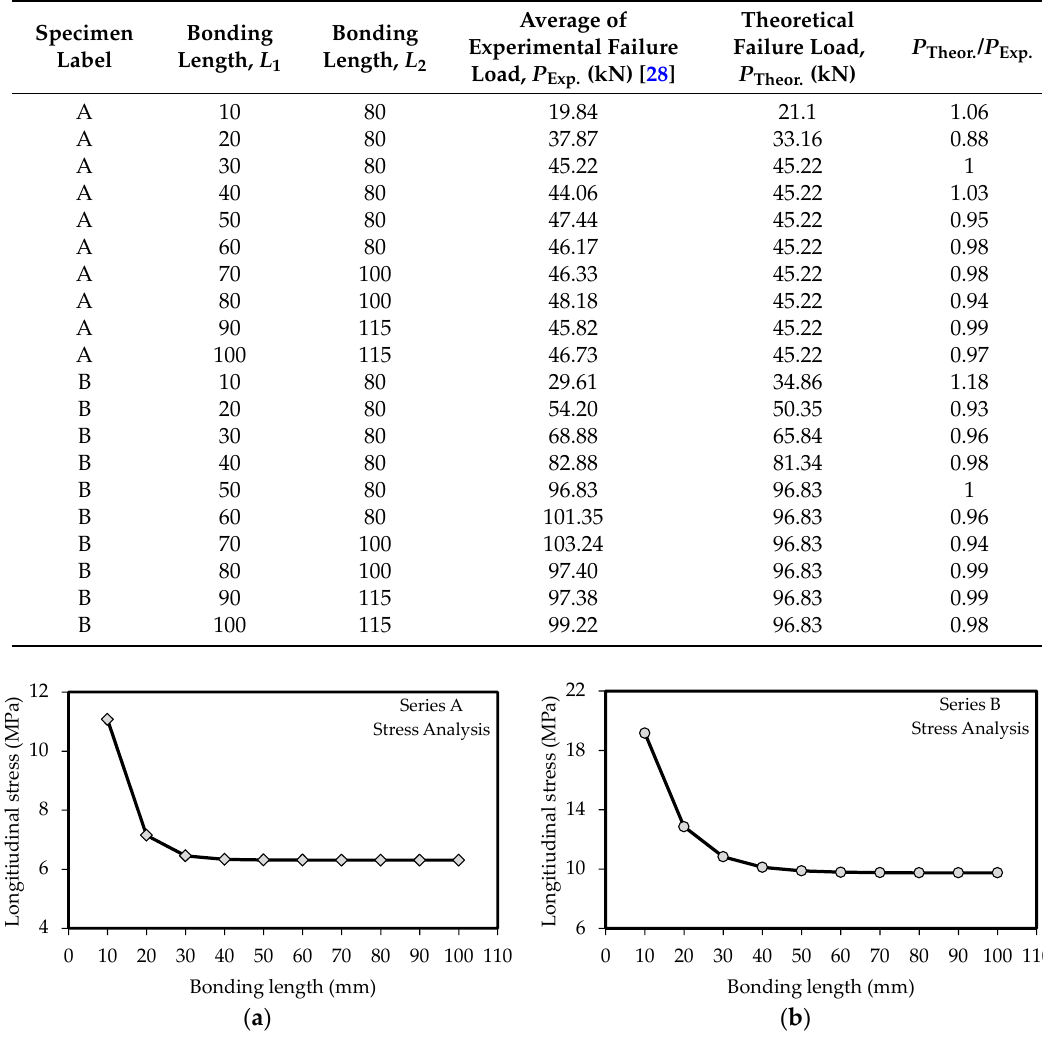
Figure 10. The variation of critical longitudinal stress for different bonding lengths (applied stress for all the specimens: 1000 MPa); ( a ) series A; ( b ) series B.